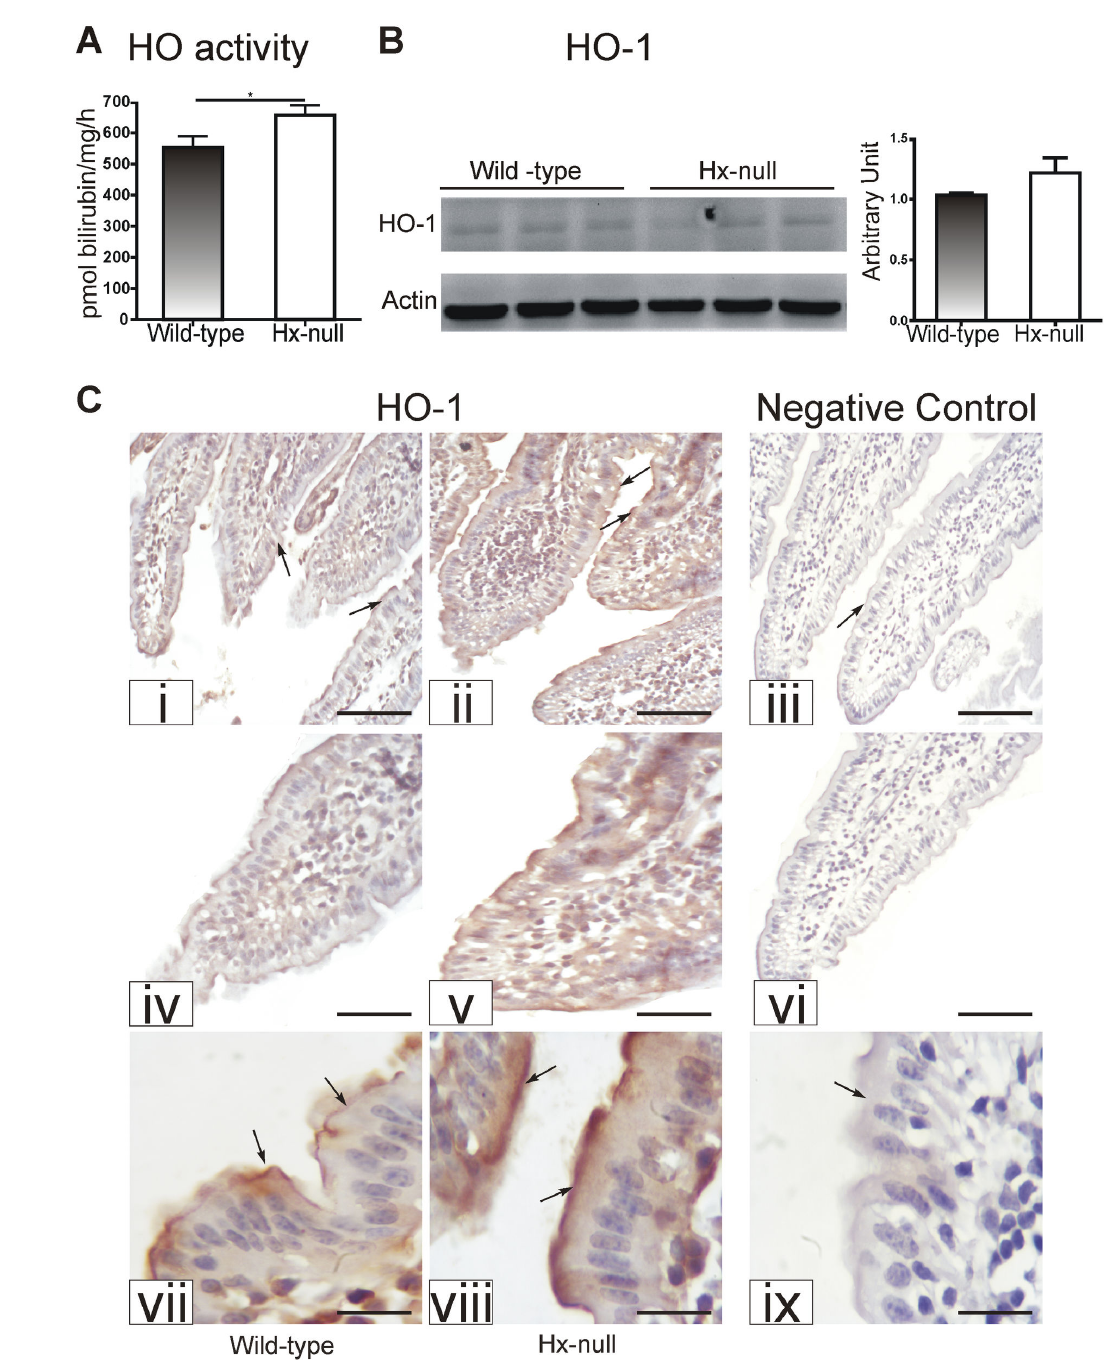
Figure 4. Hx deficiency results in enhanced heme catabolism in the duodenum. (A) HO activity in the duodenum of wild-type and Hx-null mice. Data represent mean ± SEM; n= 8 for each genotype. * = P<0.05. (B) Representative Western blot of HO-1 expression in the duodenum of wild-type and Hx-null mice. Band intensities were measured by densitometry and normalized to actin expression. Densitometry data represent mean ± SEM; n=3 for each genotype. (C) Sections of the duodenum of a wild-type mouse (i, iv, vii) and an Hx-null mouse (ii, v, viii) stained with an antibody to HO-1. Enlarged details of sections i, ii, iii are shown in iv, v, vi respectively The HO-1-positive signal was more intense in the Hx-null mouse than in the wild-type control (arrows) Sections on the right (iii, vi, ix) represent negative controls in which the primary antibody was omitted. Bar i, ii, iii = 100µm; bar iv, v, vi = 57 µm; bar vii, viii, ix = 20 µm. doi: 10.1371/journal.pone.0068146.g004 PLOS ONE |